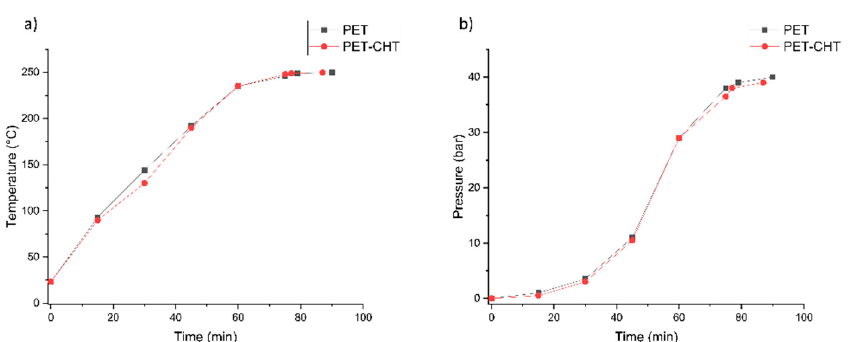
Figure 3. ( a ) Time–temperature dependence neutral hydrolysis of PET and PET–CHT. ( b ) Time– pressure dependence neutral hydrolysis of PET and PET–CHT.